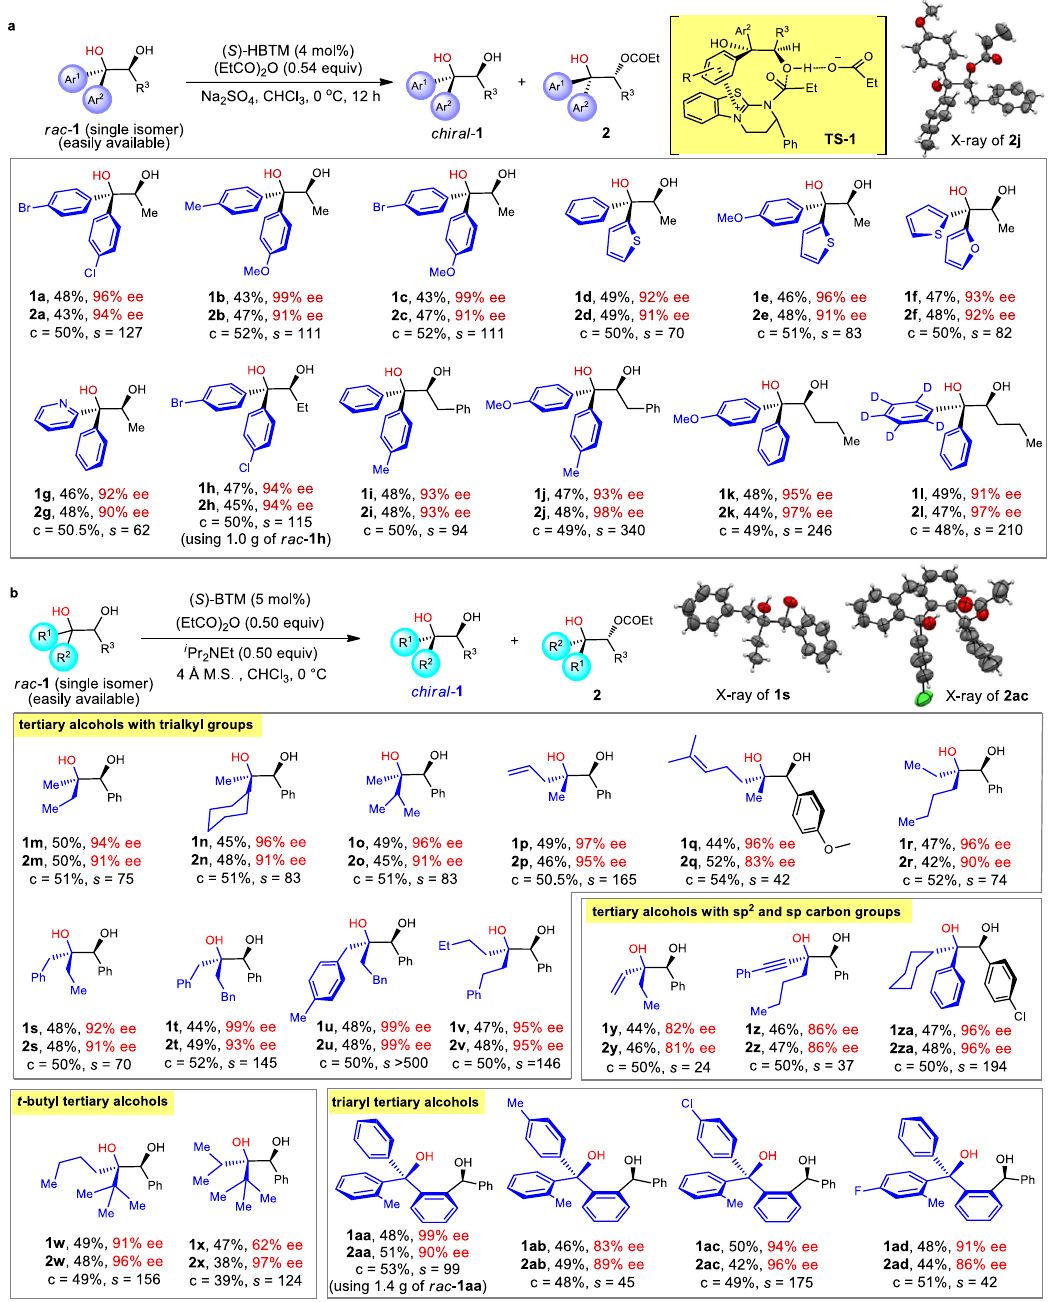
Fig. 2 Scope of tertiary alcohols. a Scope of diaryl tertiary alcohols. b Scope of dialkyl tertiary alcohols and triaryl tertiary alcohols. Variations of the standard conditions: 1n : ( S )-BTM (10 mol%), rt; 1r : anhydrous Na 2 SO 4 (150 mg), toluene, 0 °C, 11 h; 1x : rt, 20 h; 1y : − 40 °C; 1aa – 1ad : ( S )-BTM (10 mol%), Na 2 SO 4 (150 mg), toluene; 1ad : − 20 °C. c